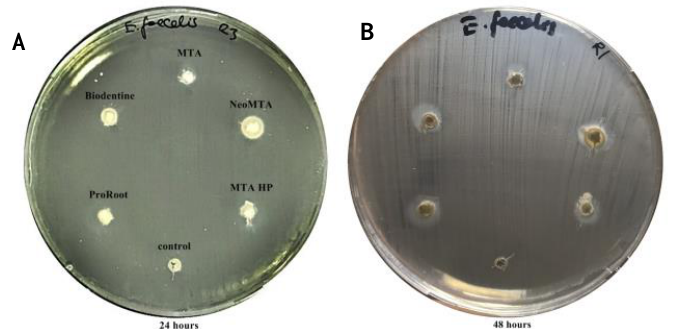
Figure 2. Zone of inhibition of five calcium silicate-based cements against E. faecalis. ( a ) inhibition zones of all calcium silicate-based cements at 24h, ( b ) inhibition zones of all calcium silicate-based cements at 48h.